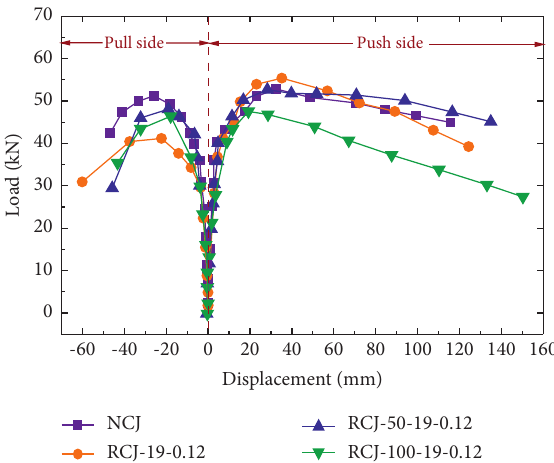
Figure 8: Load-displacement curves of specimens with different replacement rate of RCA.